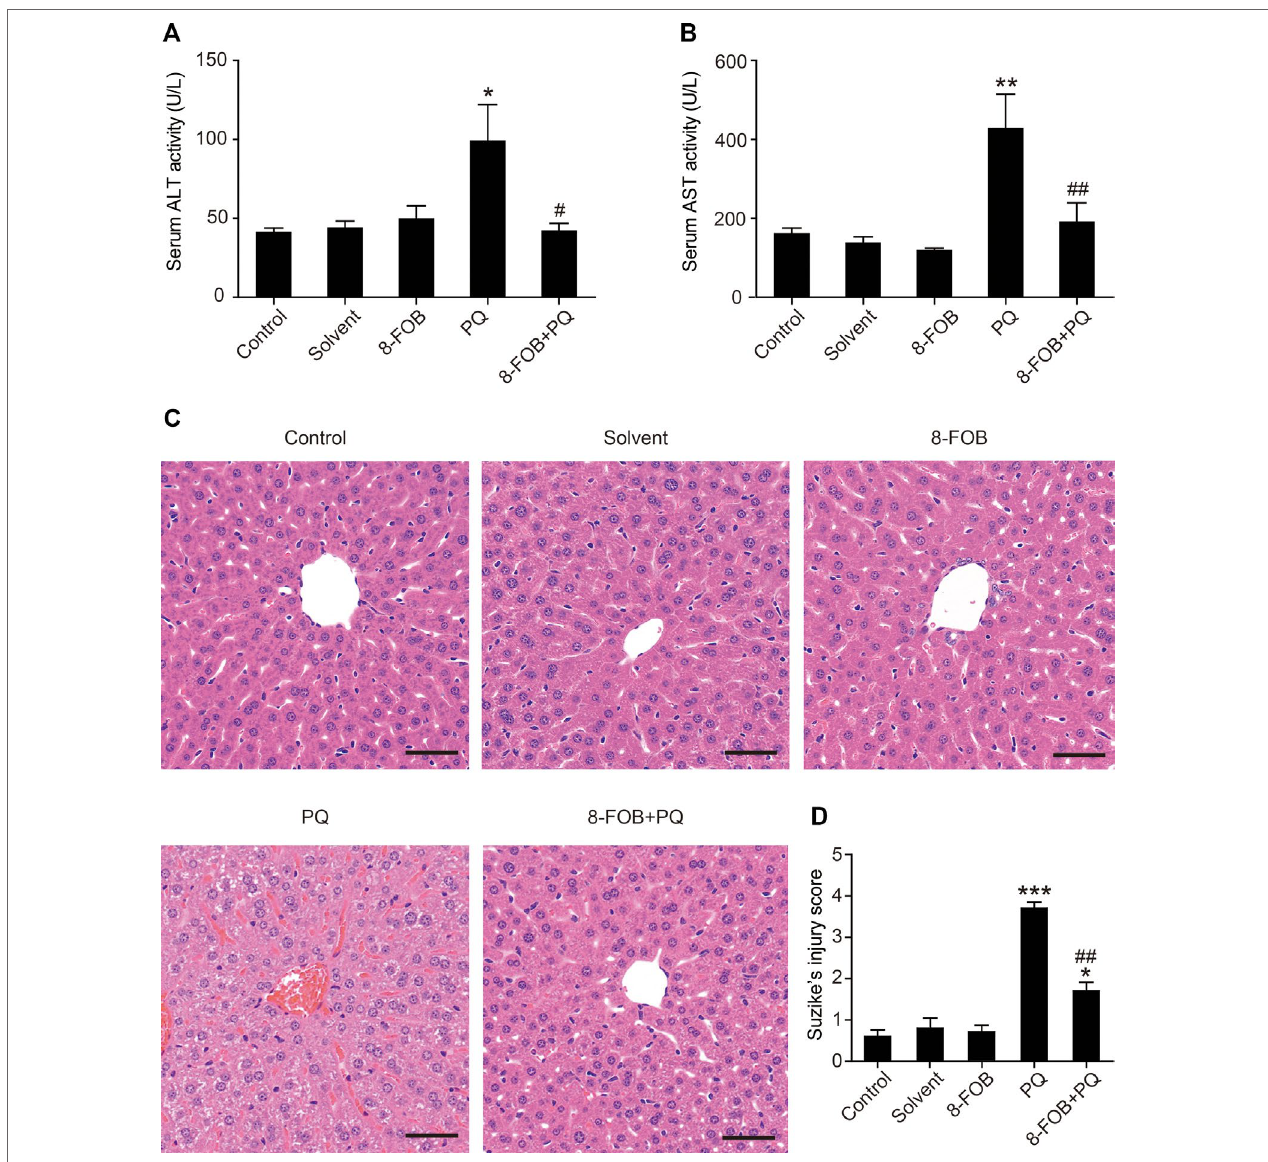
FIgURe 6 | 8-Formylophiopogonanone B (8-FOB) reduces paraquat (PQ)-induced liver injury in mice. Serum alanine transaminase (ALT) (A) and aspartate transaminase (AST) (B) activities determined at 24 h after PQ injection. The values are presented as the means ± SEM ( n = 5). * p < 0.05, ** p < 0.01 vs the control group; # p < 0.05, ## p < 0.01 vs the PQ group. (C) Representative images of the morphological observations of histopathological changes. Scale bar: 50 μm. (D) Suzike’s score of hepatic lesions analyzed quantitatively. The values are presented as the means ± SEM ( n = 10). * p < 0.05, *** p < 0.001 vs the control group; ## p < 0.01 vs the PQ